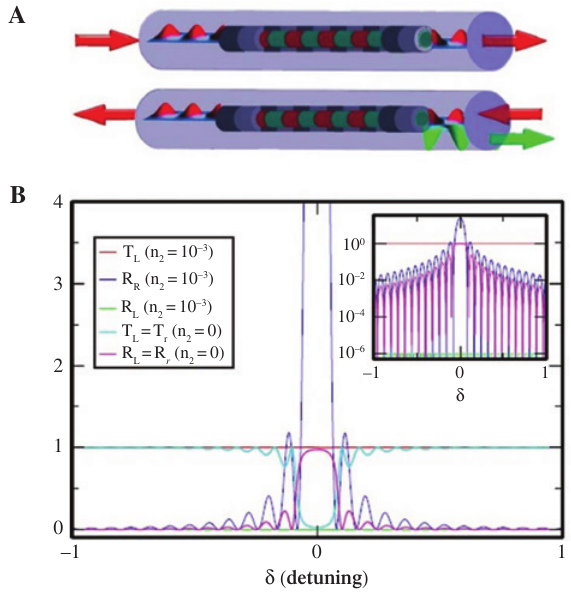
Figure 2: Unidirectional invisibility of a PT -symmetric Bragg